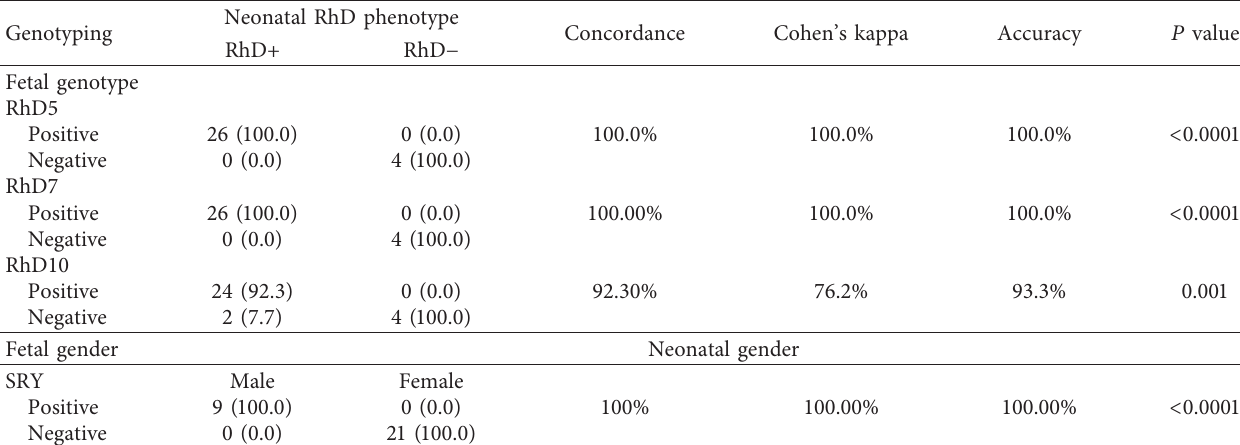
Table 3: Analytical and diagnostic measures between prenatal RhD and sex genotyping and postnatal measures.